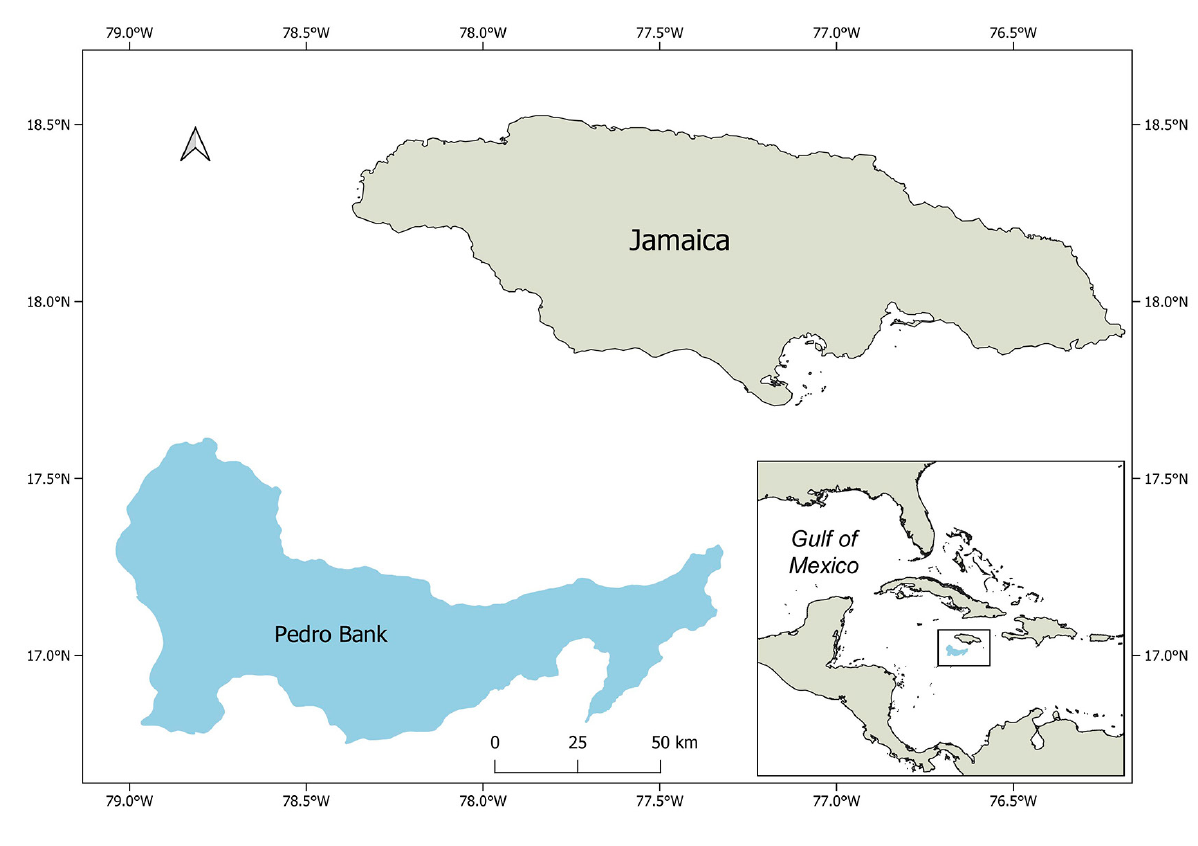
Fig. 1. – Location of the Pedro Bank, Jamaica.